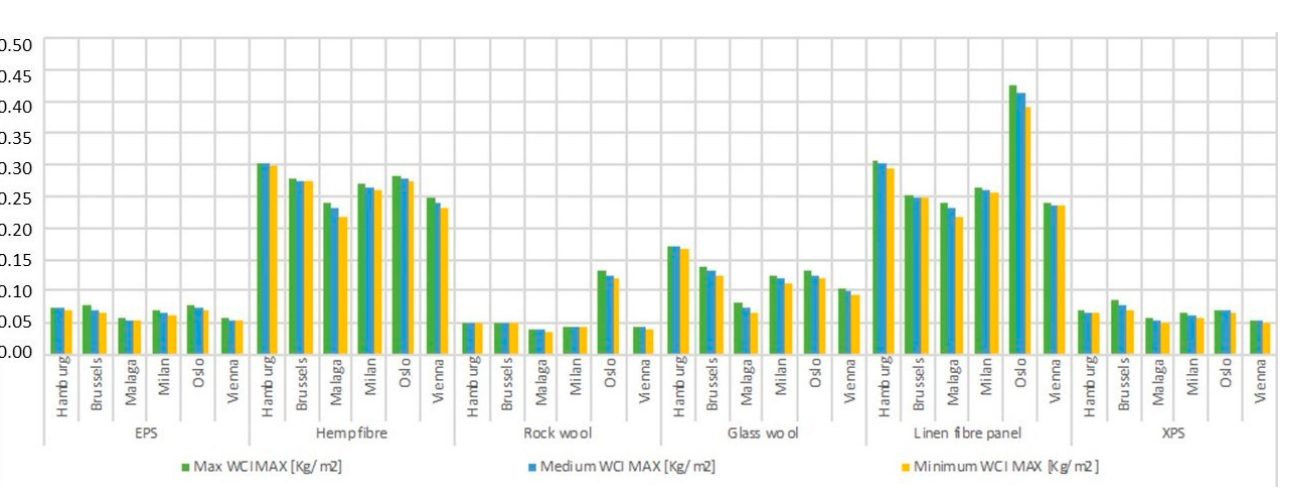
Figure 4. Results of maximum, average, and minimum IRH values (%), broken down by insulation type and application scenario.